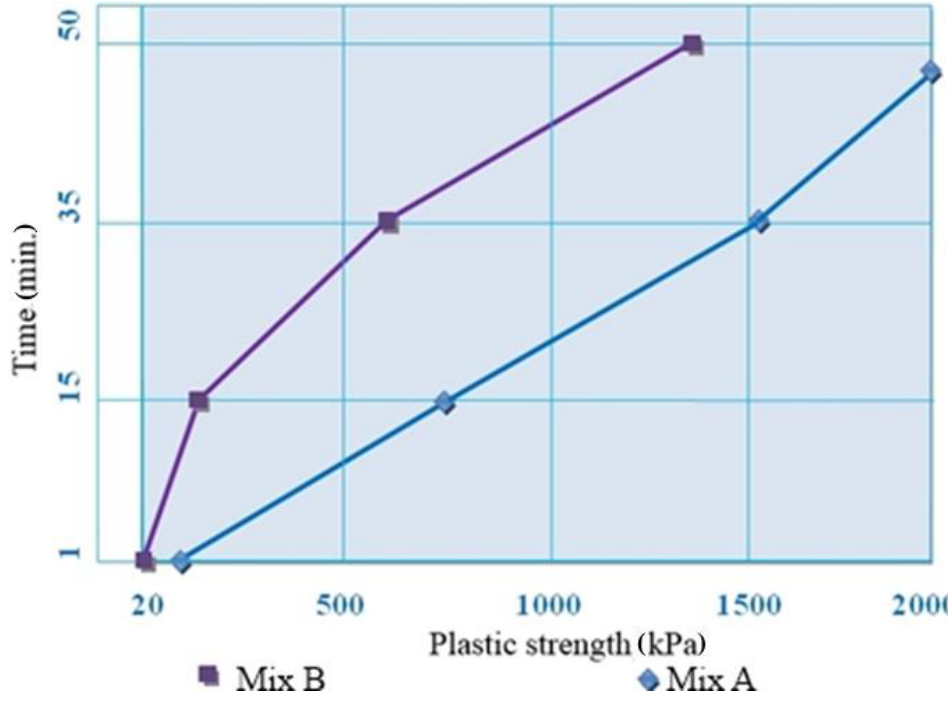
Figure 9. Plastic strength of the cement